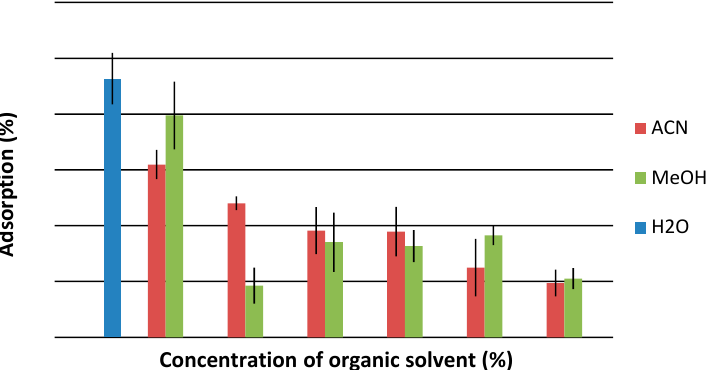
Figure 3. Influence of solvent kind and concentration on adsorption efficiency of 20 μ g BMIM PF 6 on 0.02 g of silica gel.